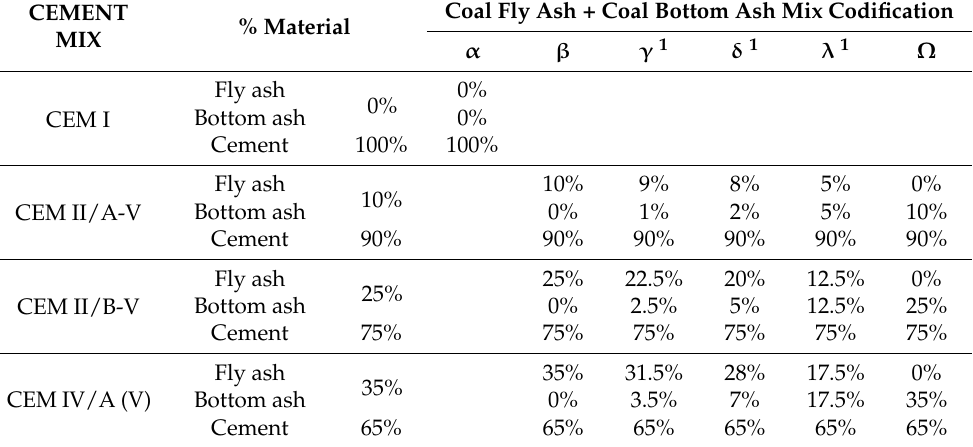
Table 1. Codification of the cement mixes of the coal bottom ash (CBA) with coal fly ash (CFA) and cement (CEM I 42.5